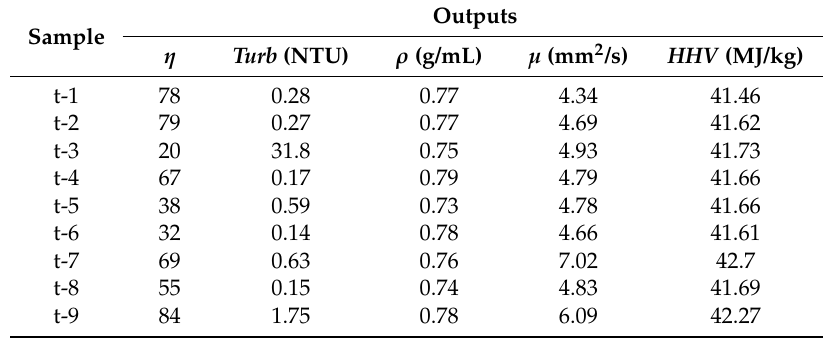
Table 7. Results of the experiments performed in the testing stage.